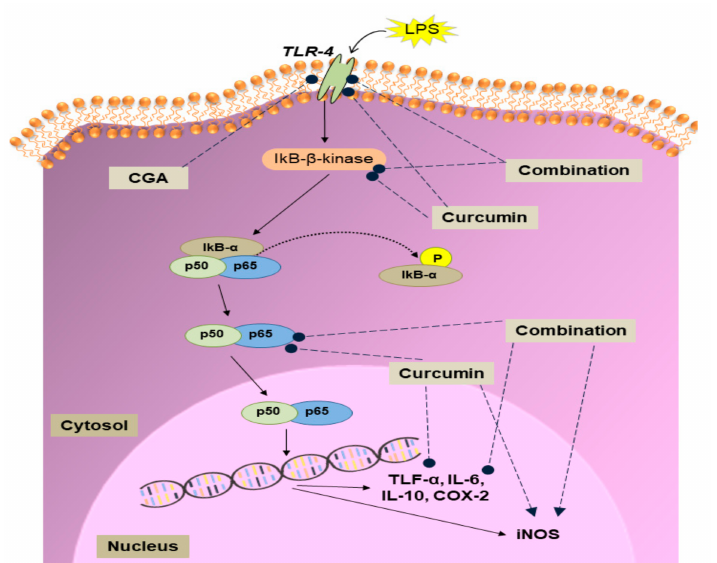
Figure 5. Summary of the e ff ects of curcumin, chlorogenic acid (CGA) and their combination on the NF- κ B signalling pathway. LPS, lipopolysaccharide; TLR-4, toll-like receptor-4; I κ B- α , inhibitor of κ B- α ; TNF- α , tumour necrosis factor- α ; IL, interleukin; COX-2, cyclooxygenase-2; iNOS, inducible nitric oxide synthase. Upregulation ( (cid:73) ) and downregulation ( • ) of mRNA